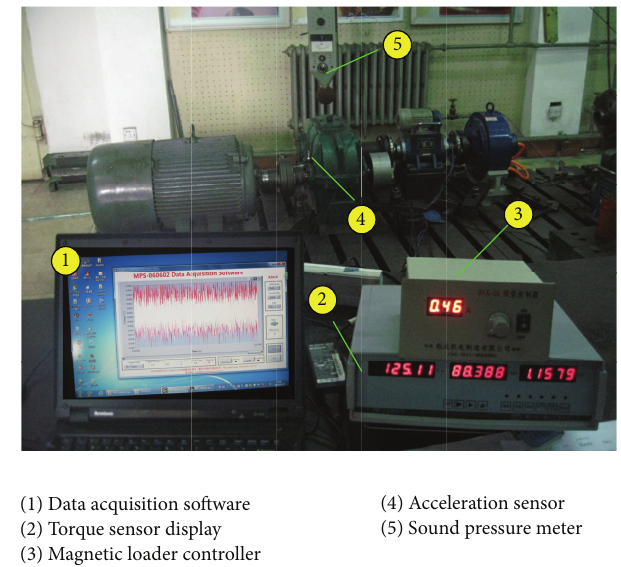
Figure 4: Test structure of the active gearbox vibration.